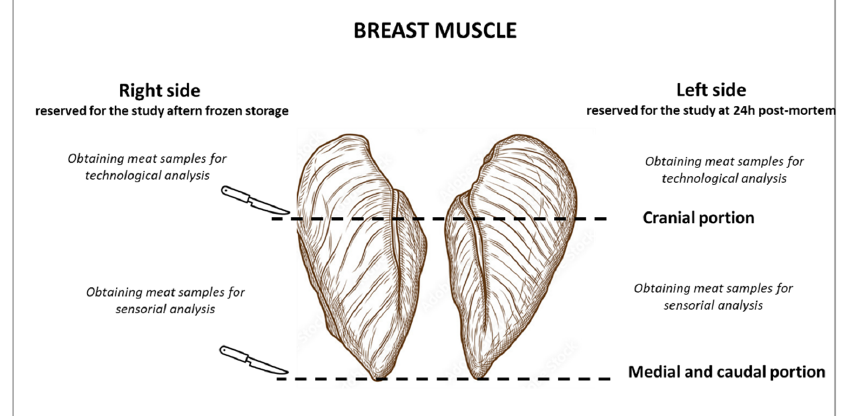
Figure 1. Sampling of the breast muscle in relation to the analyses of the study.